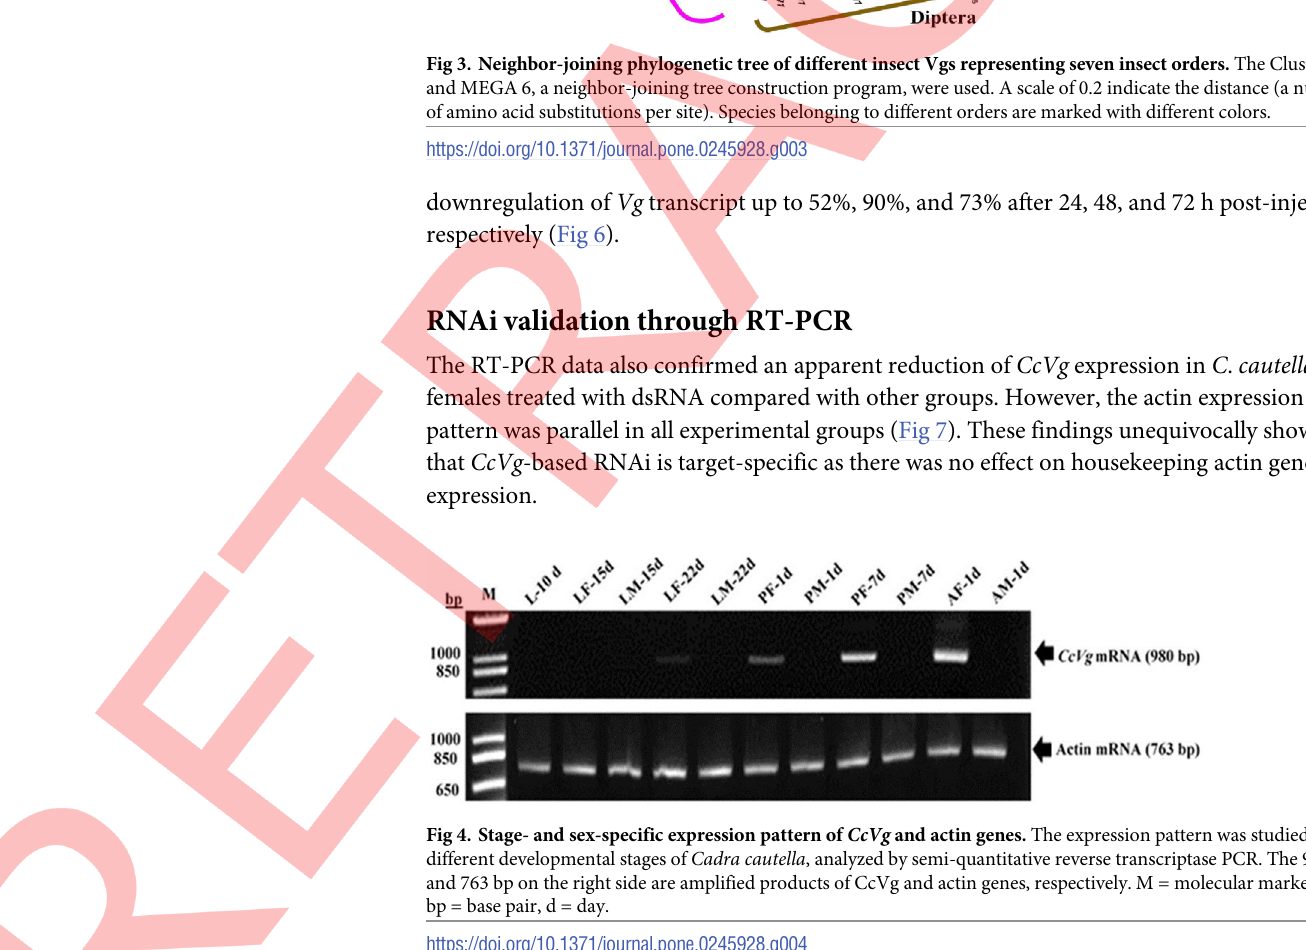
Fig 4. Stage- and sex-specific expression pattern of CcVg and actin genes. The expression pattern was studied from different developmental stages of Cadra cautella , analyzed by semi-quantitative reverse transcriptase PCR. The 980 bp and 763 bp on the right side are amplified products of CcVg and actin genes, respectively. M = molecular marker, bp = base pair, d =